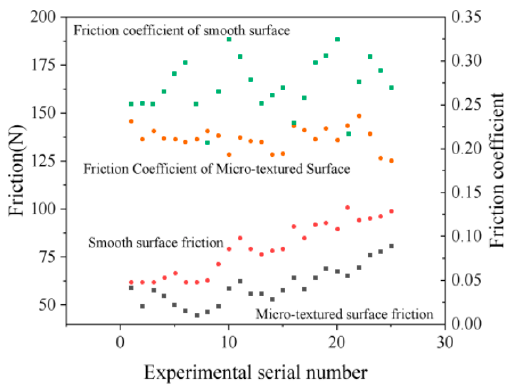
Figure 3. Diagram of comparative analysis of friction force and friction coefficient.